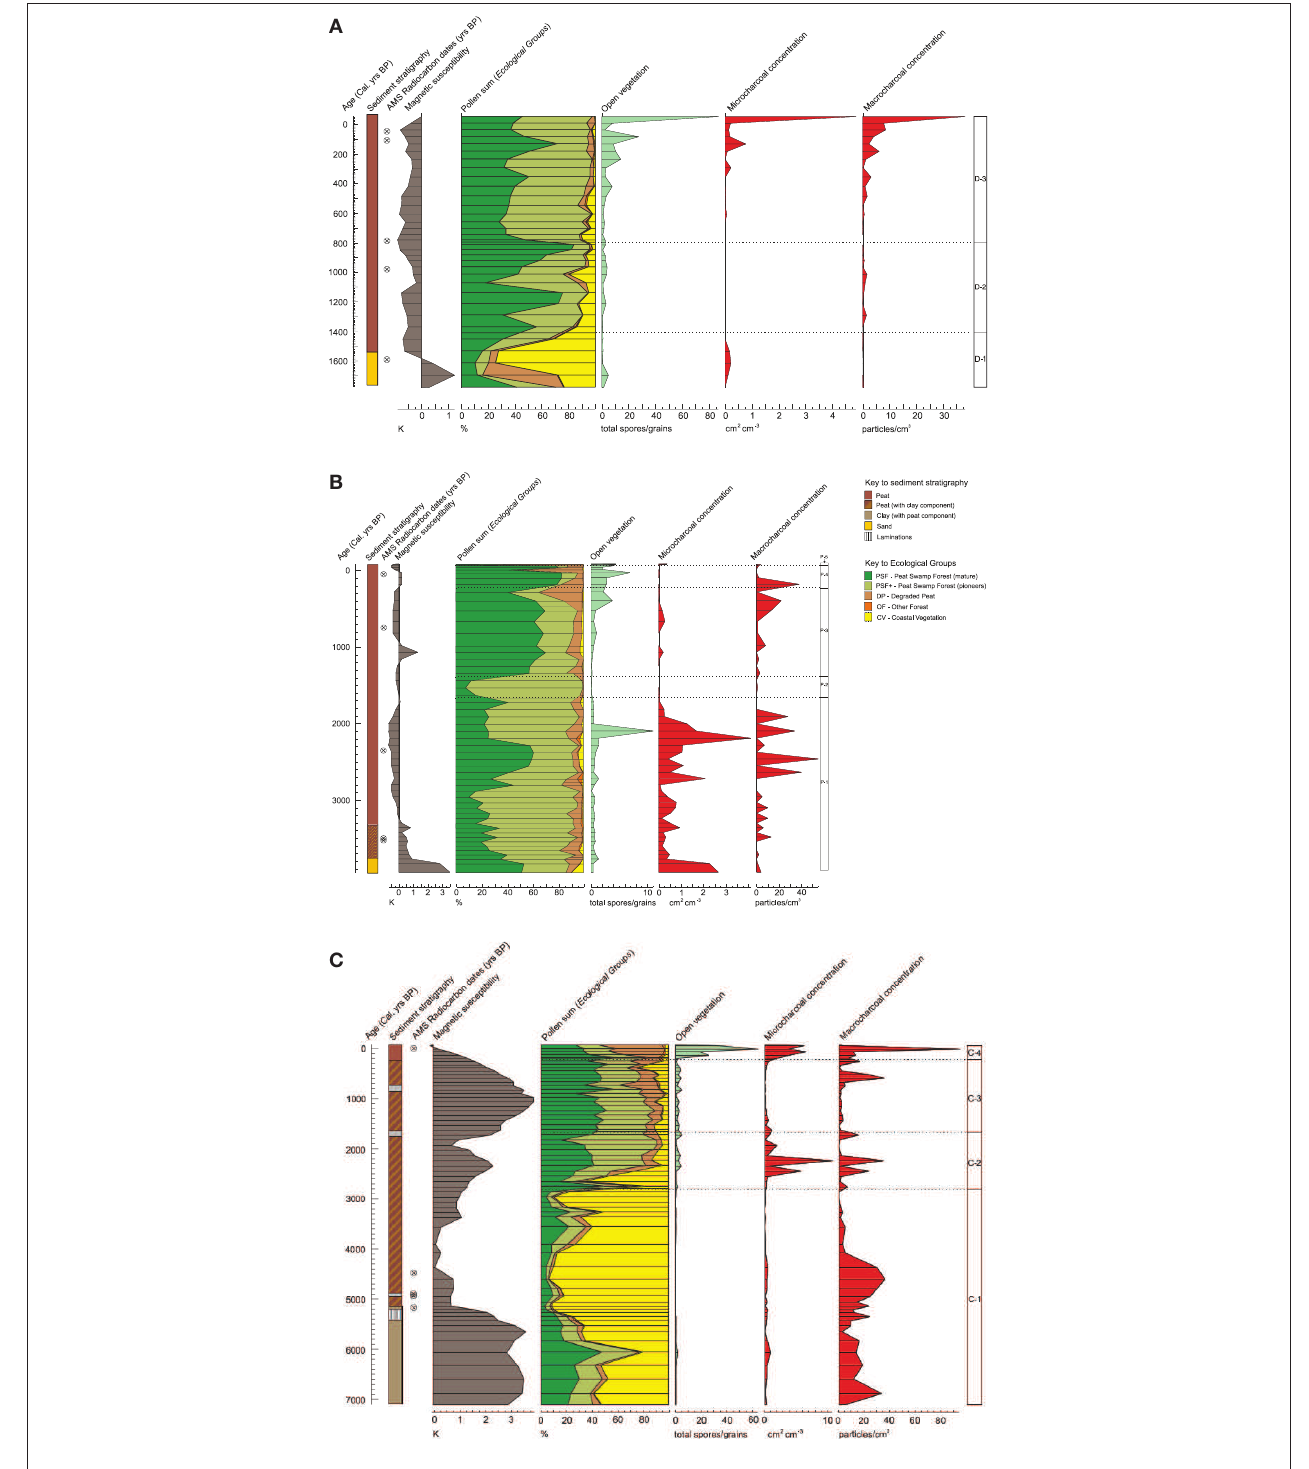
FIGURE 3 | Pollen summary diagrams for each site: (A) Deforested Peatland; (B) Peat Swamp Fragment; and (C) Converted Peatland, showing the sediment stratigraphy, magnetic susceptibility, five different ecological groups (represented by the following colors: PSF dark green, PSF + light green, DP brown, OF orange and CV yellow), open vegetation (light gray), and macrocharcoal and microcharcoal (red). Significant pollen zones are shown for each (labeled D-, P-, and C-, respectively). TotPSF% comprises the sum of PSF% and PSF + %, and is represented by the division between PSF + % and DP%.